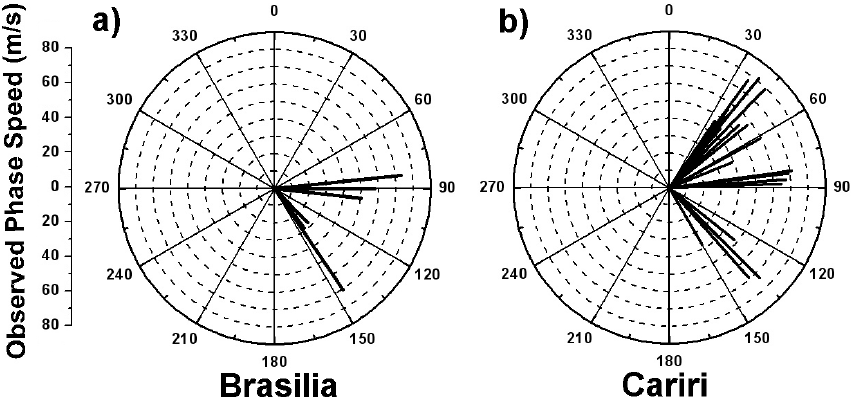
Fig. 9. Velocity plots showing the azimuthal distribution of the medium-scale waves. Note the similarity with the small-scale wave data of Fig. 4.